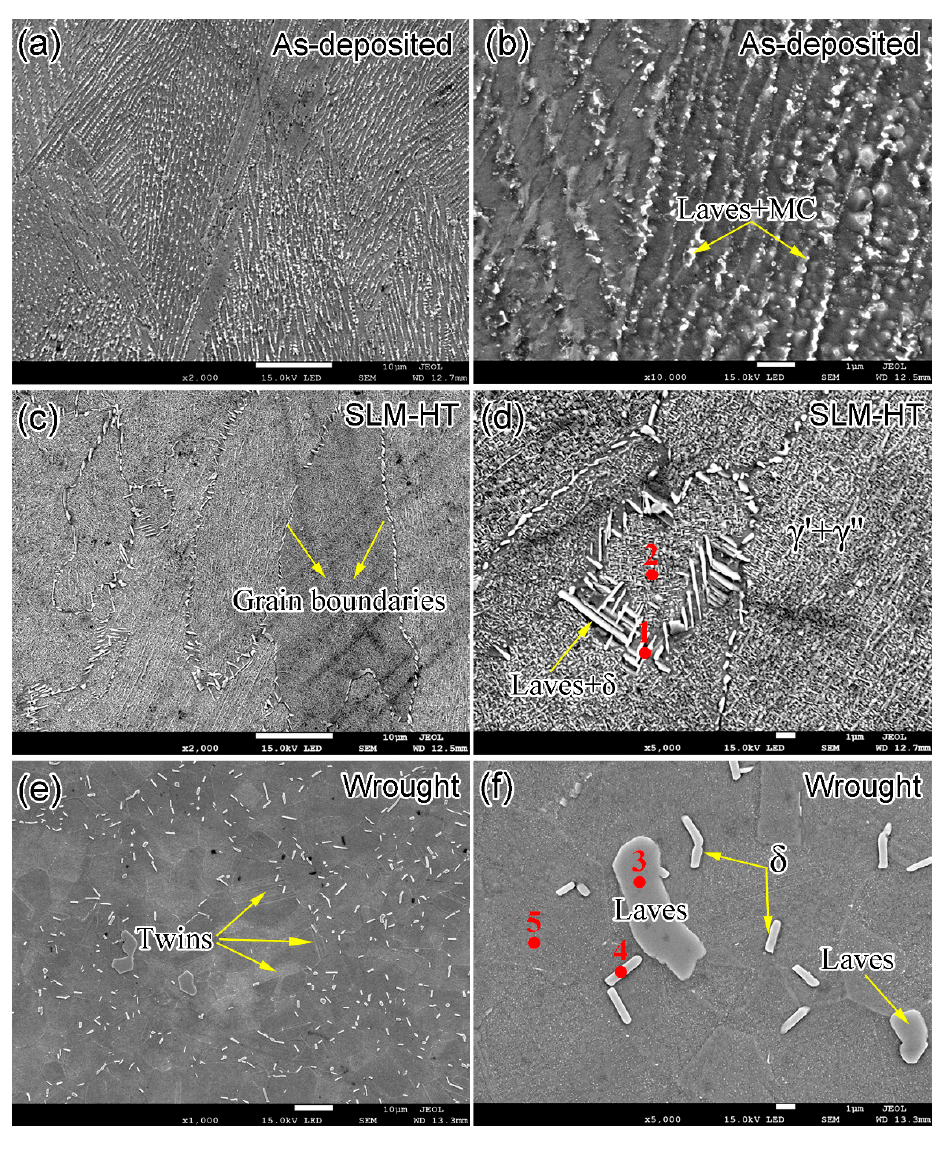
Figure 3. SEM images showing the microstructure of ( a , b ) as-deposited SLM IN718, ( c , d ) SLM plus heat treatment (SLM-HT) and ( e , f ) the wrought counterpart. Solid red circles are EDS test positions and the results are listed in Table 2.